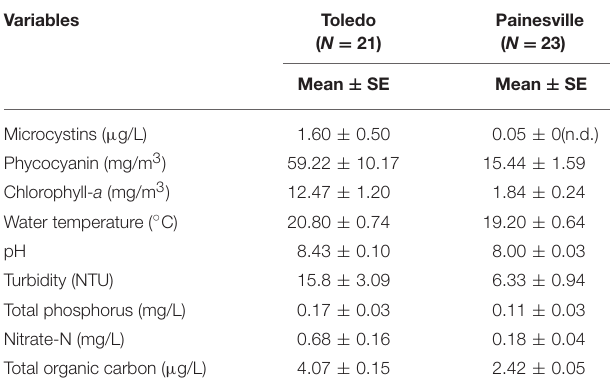
TABLE 1 | Summary of environmental parameters at the Toledo and Painesville water plants.